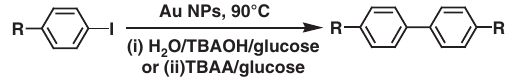
(SR) (ball-stick model); (B) space-filling 25 18